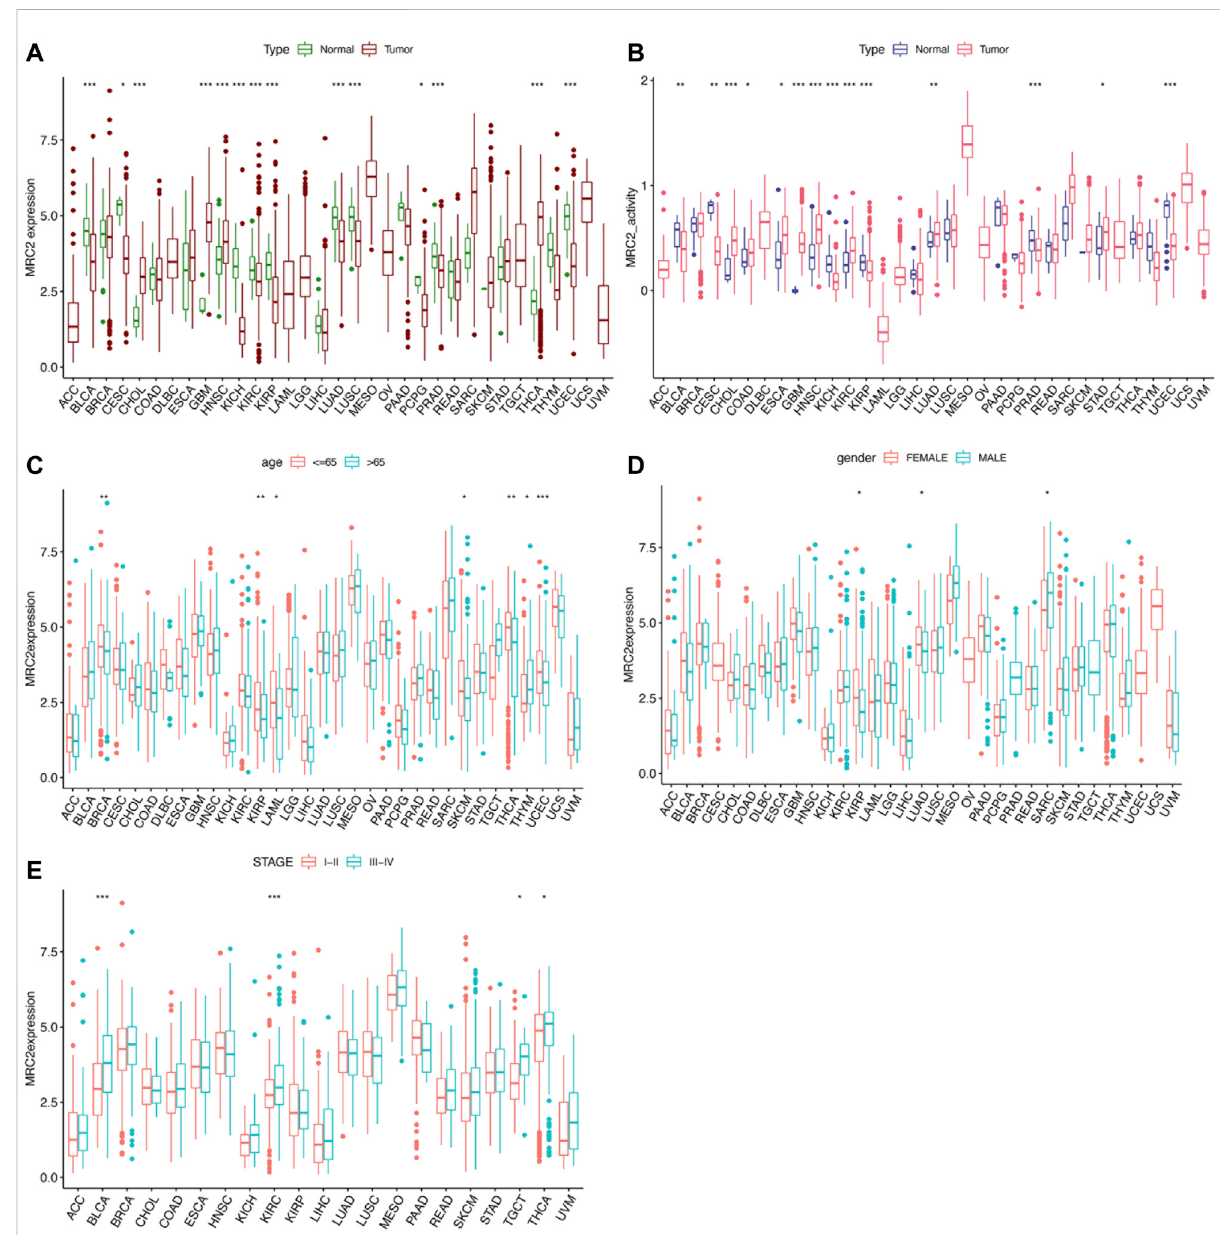
FIGURE 1 The clinical correlation and activity of MRC2. (A) The differential expression analysis betweentumor and normal groups of MRC2 in 33 cancers; (B) The different activity analysis between tumor and normal groups of MRC2 in 33 cancers; (C) The correlation between age and MRC2. (D) ; The correlation between gender and MRC2; (E) The correlation between stage and MRC2. “ ** ” indicates p < 0.01 and “ *** ” indicates p <